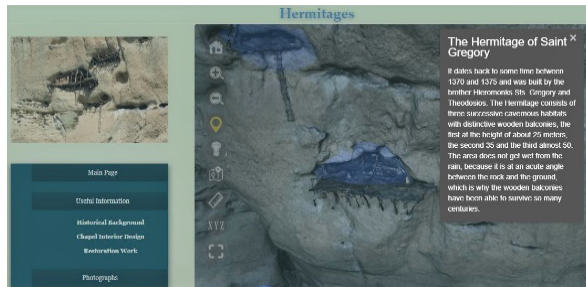
Figure 11. Screenshot from the display of historic and religious information via the METEORA